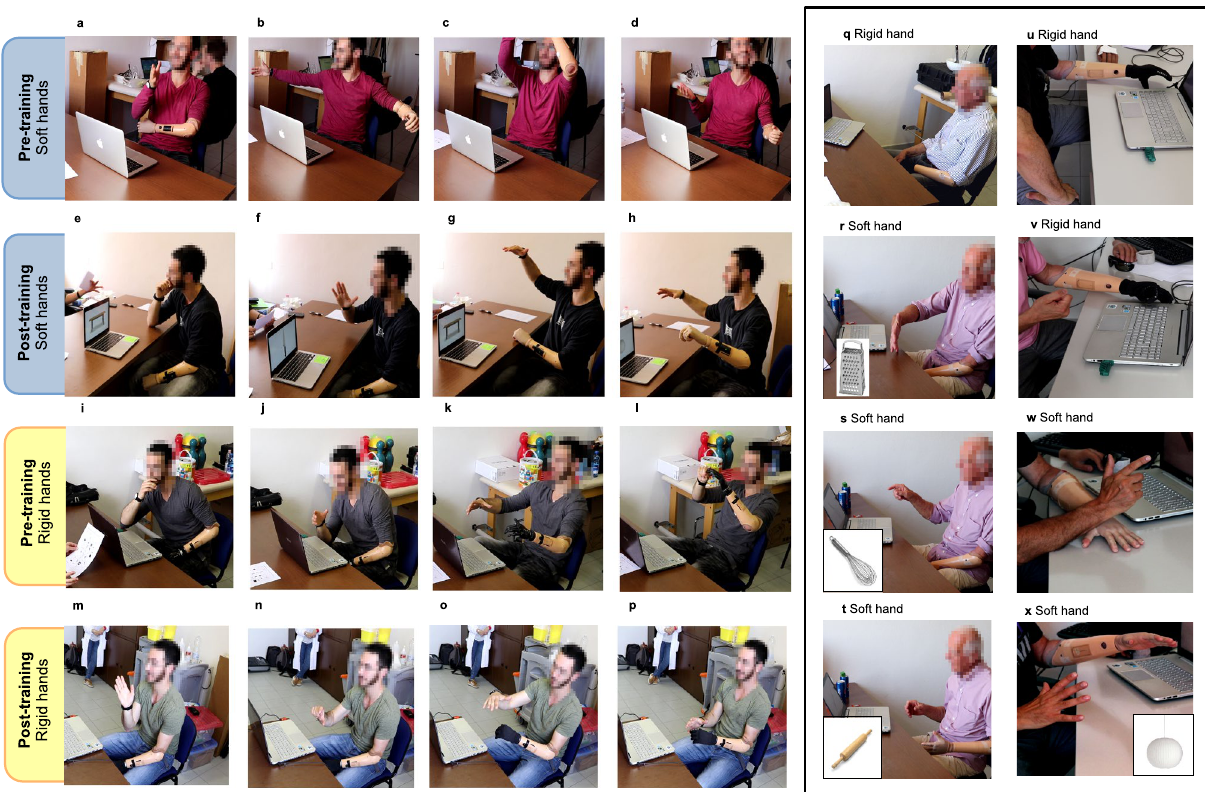
Figure 6. Body ownership test. ( a – p ) Show examples of the test executed by s 5 in different conditions. ( q – t ) Present frames of the experiment with s 4 , while ( u – x ) with s 3